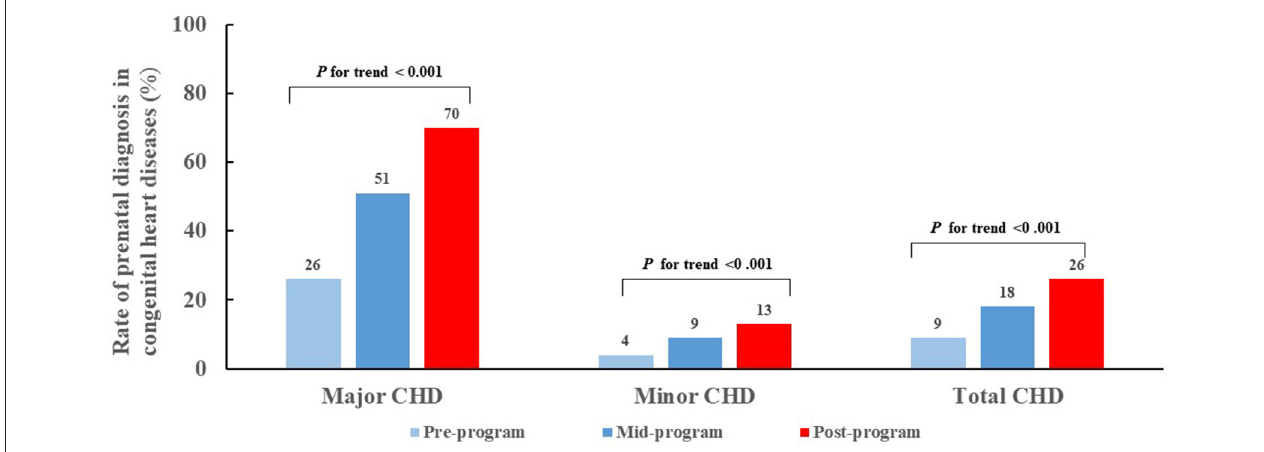
FIGURE 1 | Trend for prenatal diagnosis rates for congenital heart diseases during pre-, mid- and post-program time intervals, by major and minor severity. CHD, congenital heart disease.